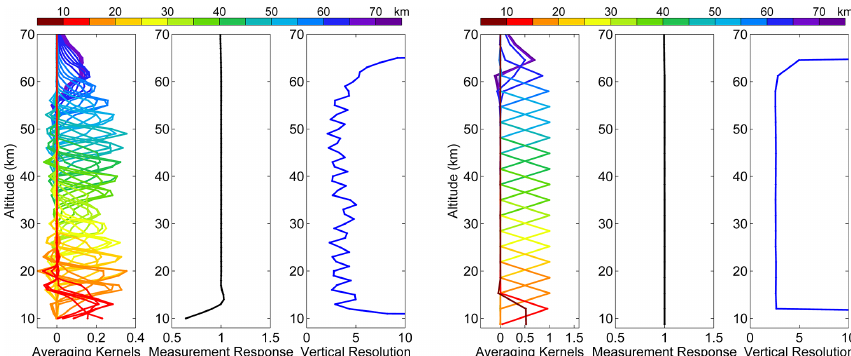
Figure 1. Averaging kernels, measurement response and vertical resolution from SCIAMACHY V2.9 (left panel) and V3.0 (right panel). Note that the x axis range is different between the two panels. The example is calculated for orbit 21223; measured at 17:36UTC on 22 March 2006; solar zenith angle of 74.95 ◦ ; at 75.44 ◦ N and 93.58 ◦